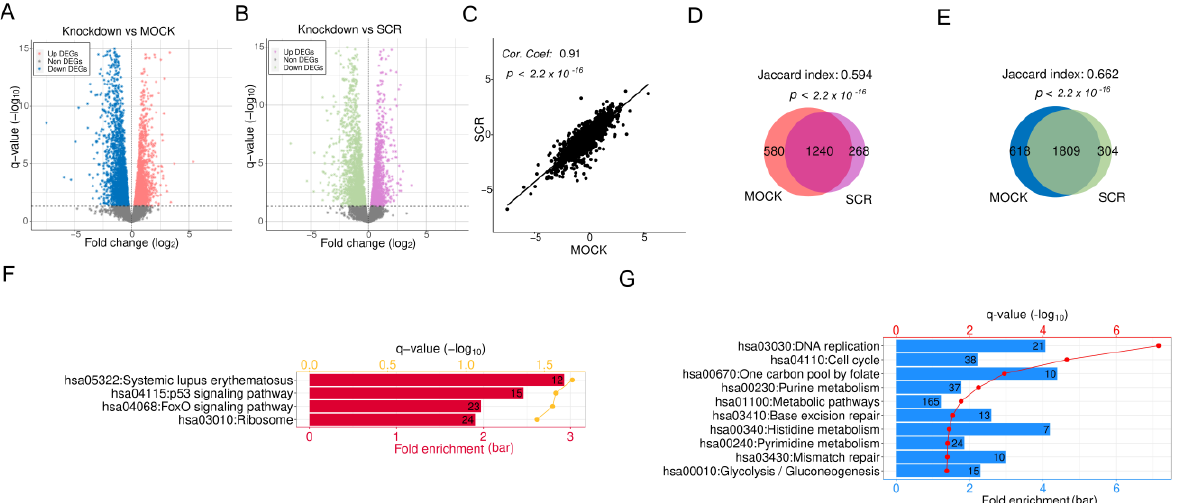
Figure 1. RNA-seq analysis of APEX1 knockdown (KD) in human retinal endothelial cells (HRECs). ( A ) Volcano plot of APEX1 KD in HRECs compared with mock transfected (MOCK) HRECs. The pink and blue points represent upregulated and downregulated DEGs, respectively. ( B ) Volcano plot of APEX1 KD compared with scrambled siRNA-transfected cells (SCR), where the purple and green dots indicate up- and downregulated DEGs, respectively. ( C ) Fold changes (FCs) of gene expression upon APEX1 KD compared to two controls, MOCK ( x -axis) and SCR ( y -axis). ( D ) Overlap of upregulated DEGs between KD vs. MOCK and KD vs. SCR. ( E ) Overlap of downregulated DEGs compared to two controls. Selected KEGG pathways significantly overrepresented in ( F ) upregulated DEGs and ( G ) downregulated DEGs.